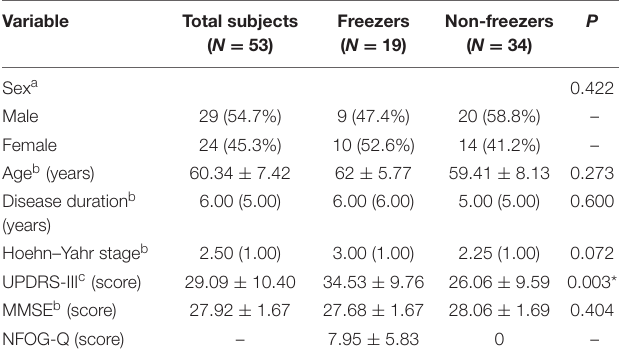
TABLE 1 | Characteristics of PD patients and difference analysis of the freezer and non-freezer groups.